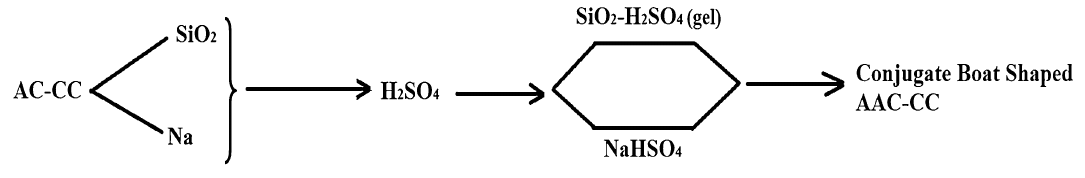
Figure 9. Basic reaction of AC-CC to produce